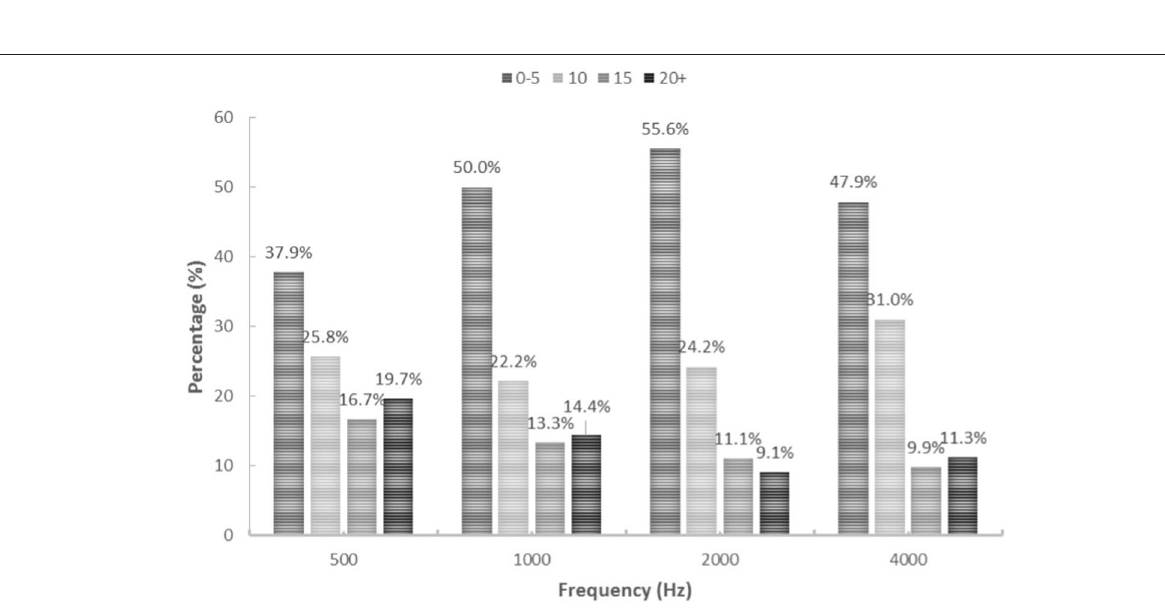
FIGURE 3 | Distribution of ASSR and PTA differences for each frequency. Percentages presented for 0–5 dB, 10 dB, 15 dB and 20 dB + (and over) threshold